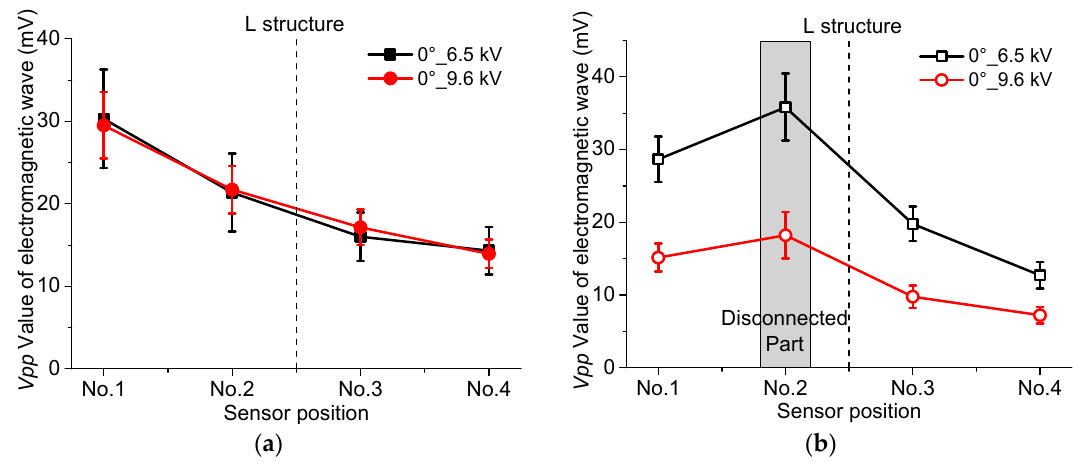
Figure 7. The Vpp attenuation characteristics of UHF signals induced by protrusion defect ( θ = 0°). ( a ) DS closed; ( b ) DS open.